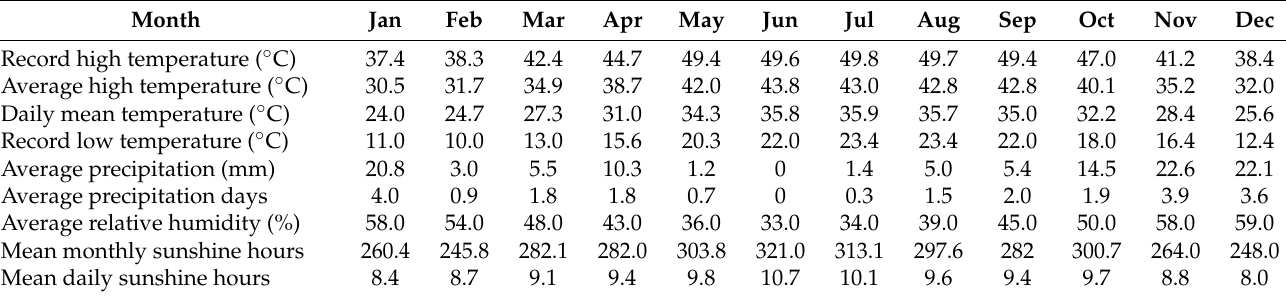
Table 1. Meteorological factors in the survey